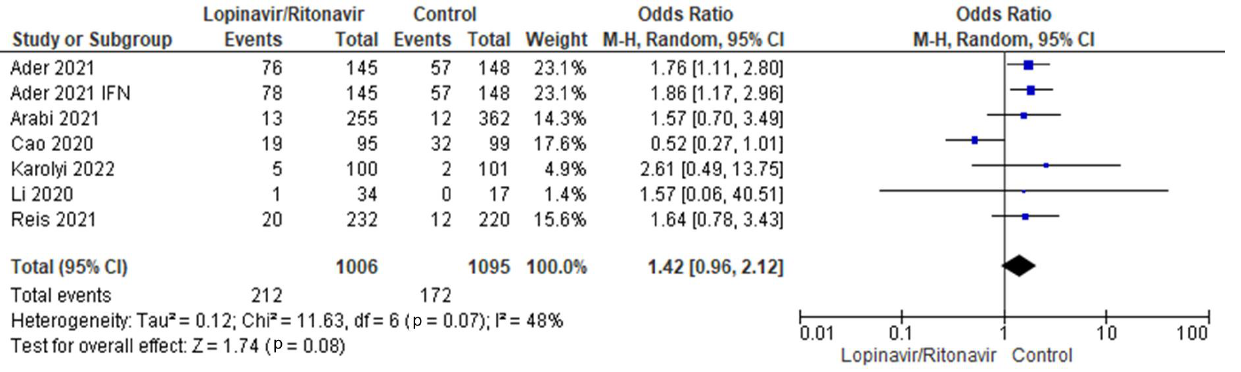
Figure 7. Forest plot analysis of serious adverse events. The combined point estimate is shown as a black diamond. The diamond and squares (together with the 95% CIs) located beyond the vertical line (indicating the unit value) show that a result was statistically significant.